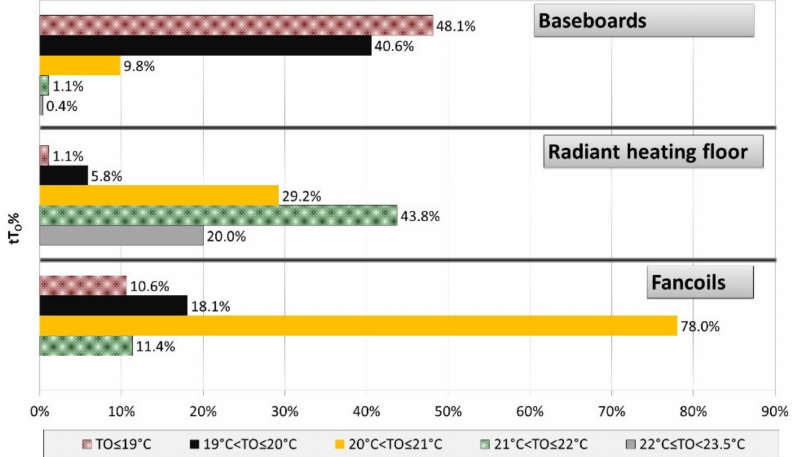
Figure 6. Percentage of time in comfort range for all systems—operative